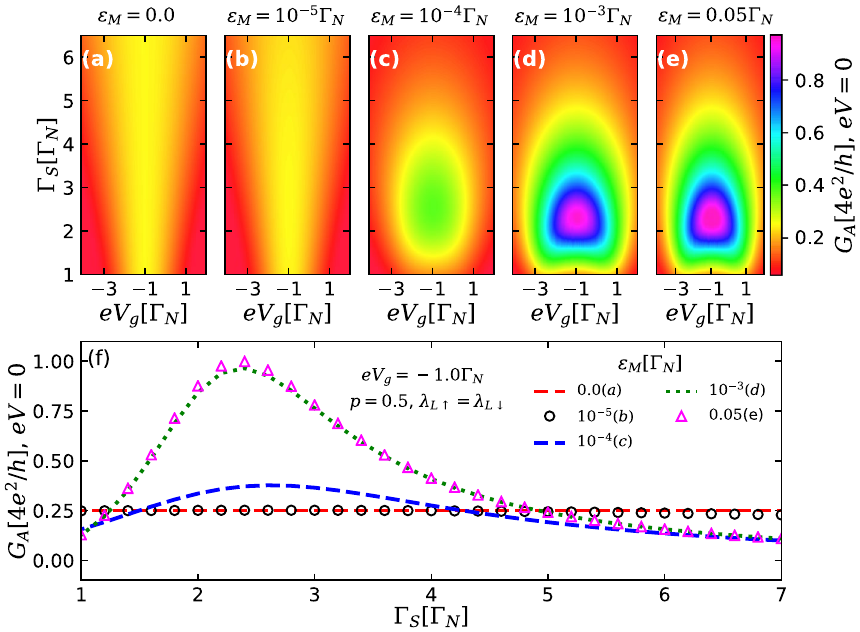
Figure 5. ( a – e ) Color scale plots of the Andreev conductance G A [Eq. (5)] at zero-bias as a function of the 0.5 ), for five distinct QD-S hybridization strength Ŵ S and QD gate-voltage eV g for spin symmetric case ( p = values of the parameter ε M defining the overlap between the MBSs well-localized at the ends of the TSC 0 ). One clearly sees that condition G 0 ) e 2 / h is satisfied along the open vertical section ( (cid:31) R σ A ( eV = = = line ( isoconductance line) in the left two panels corresponding to highly isoladed MBSs, and along the closed line in the right three panels, corresponding to highly overlapping MBSs. In this latter case, the value of the conductance inside the line exceeds e 2 / h ( f ): Andreev conductance at zero-bias plotted as a function of Ŵ S with 1.0 Ŵ eV g N , for the same values of ε M as in the upper = −